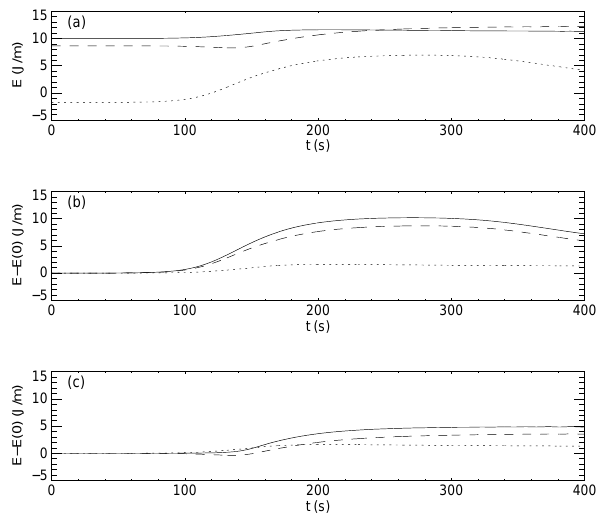
Fig. 8. Energetics for an ISW shoaling through a turning point. (a) Solid curve: ¯ E a . Dots: ¯ E kp . Dashed: ¯ E k2 . (b) Dots: ¯ E a − ¯ E ¯ E − ¯ E a ( 0 ) . Dashed: kp kp ( 0 ) . Solid curve: their sum. (c) Dots: ¯ E ¯ E ¯ E − ¯ E a − a ( 0 ) . Dashed: k2 k2 ( 0 ) . Solid curve: their sum.